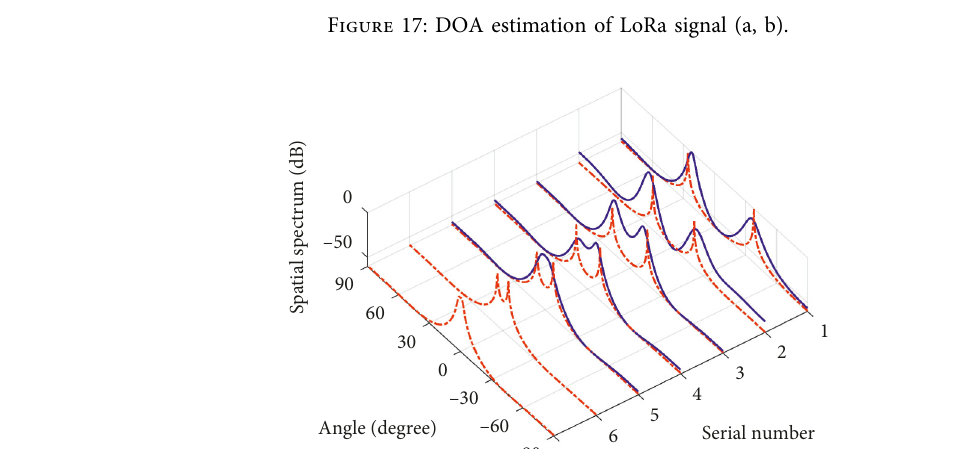
Figure 17: DOA estimation of LoRa signal (a,